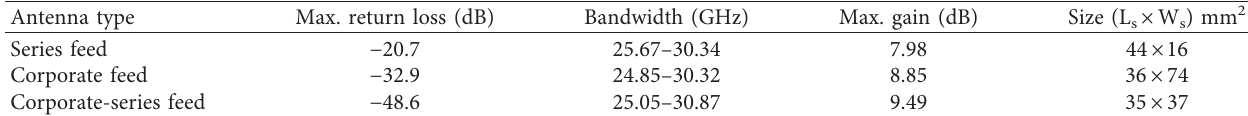
Table 5: Comparison between array antenna